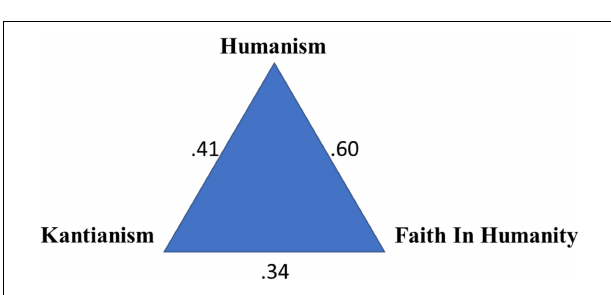
FIGURE 3 | Correlations among light triad subscales. All correlations significant at p < 0.01. N = 1,518.